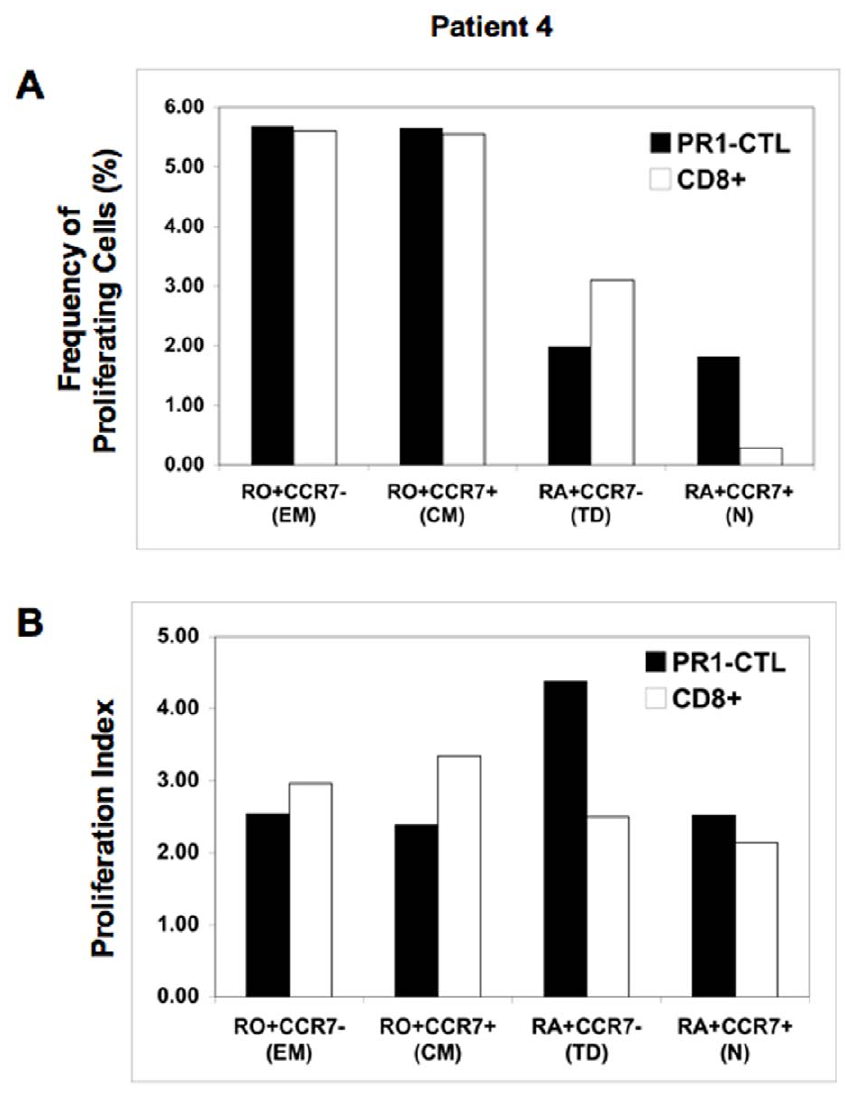
Figure 5. PR1-CTL of all differentiation phenotypes proliferate. Lin- CD8 + cells from patient 4 were sorted into effector memory (EM), central memory (CM), terminally differentiated (TD) and naı¨ve (N) populations, then labeled with CFSE and stimulated with OKT3 + anti-CD28 antibodies. After 80 hours, cells were labeled with PR1/HLA-A2 tetramer and analyzed for evidence of proliferation by CFSE dilution. (A) The upper panel shows the frequency of proliferating PR1-CTL compared to total CD8 + T cells, and (B) the lower panel shows proliferation indices of PR1-CTL compared to total CD8 + T cells.